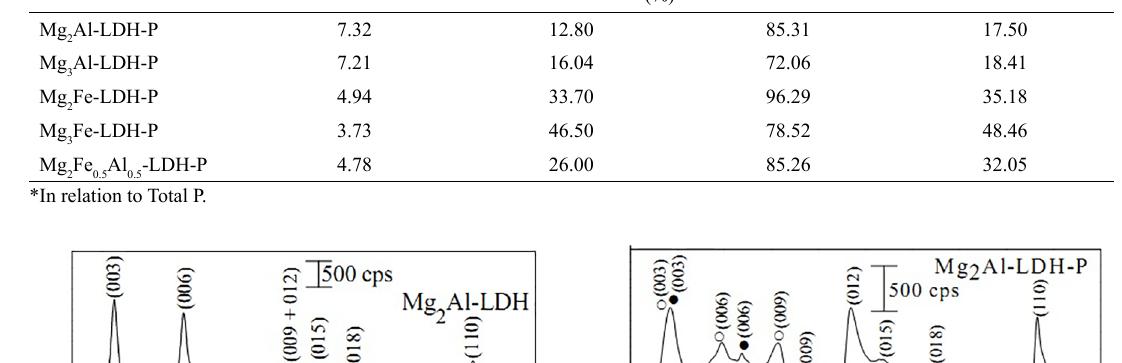
Table 3. Contents of total P Material